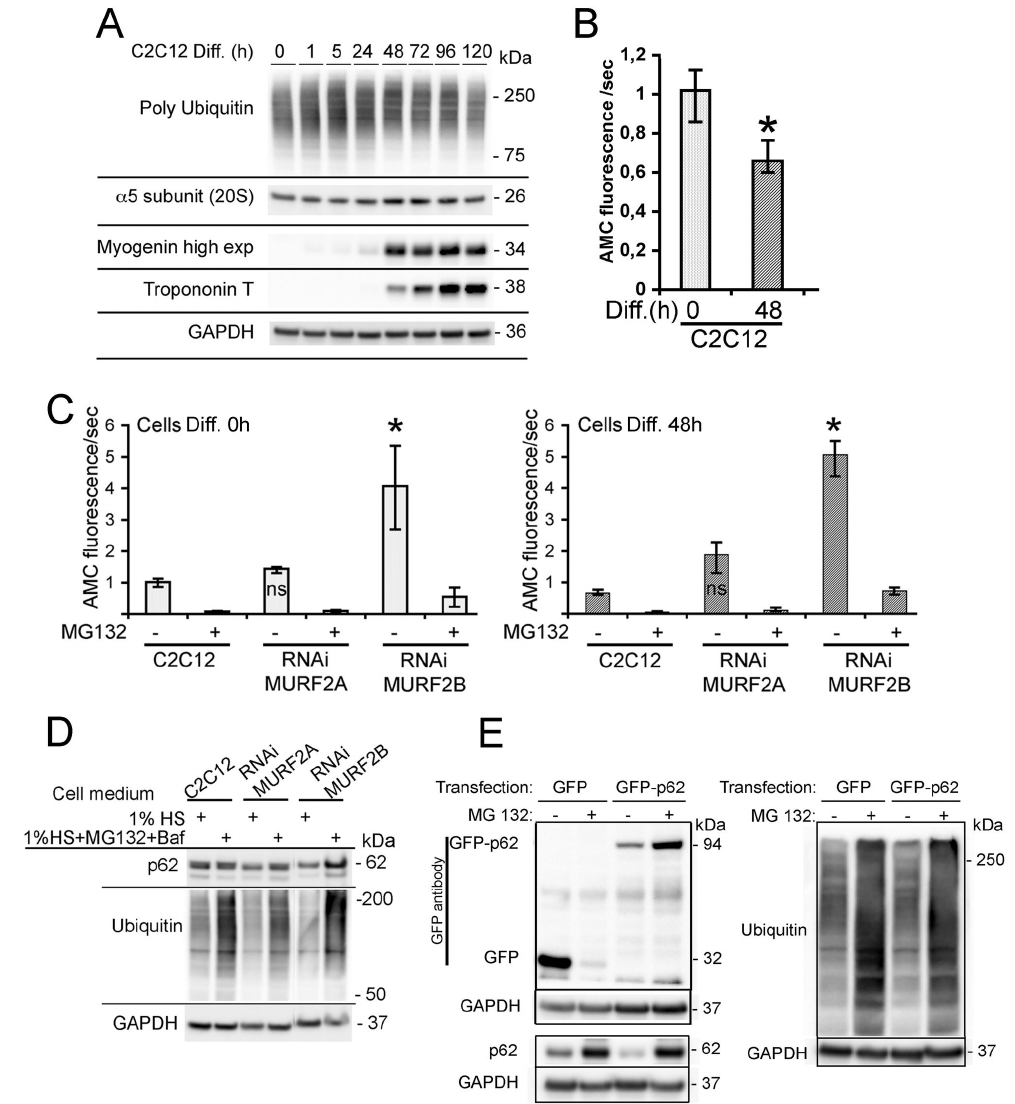
Figure 9. (A) Representative immunoblots of C2C12 lysates probed with poly ubiquitin, the α5 subunit of the 20S proteasome, myogenin, Troponin T and GAPDH antibodies. Lysates were obtained at various times of differentiation (Diff.). (B) Activity of the 20S proteasome in C2C12 cells. Proteolytic 20S proteasome chymotrypsin-like activity of the indicated undifferentiated (0h) and differentiated (48h) C2C12 cells was determined measuring the amidomethylcoumarin (AMC) generated as the cleavage product of the fluorogenic substrat succinyl-leucine-leucine-valine-tyrosine-7 amido-4-methyl-coumarin. Differences were evaluated by the Kruskal-Wallis test. Medians and quartiles are shown in the histograms. Compared to C2C12 myoblasts (Diff. 0h), myotubes (Diff. 48h) showed significant differences (*, P<0.05). (C) Activity of the 20S proteasome in various RNAi cell lines. The proteolytic 20S proteasome chymotrypsin-like activity was determined for undifferentiated (0h) and differentiated (48h) cells as previously mentioned for C2C12 cells. Compared to C2C12 and RNAi MURF2A, RNAi MURF2B cells showed significant increase of their 20S proteasome activity (*, P<0.05). (D) Effect of UPS and autophagic inhibition on p62 expression in C2C12 and MURF2 RNAi cells. After 24h of differentiation in 1% horse serum medium (1% HS), cells were shifted to fresh differentiation medium (1% HS) or treated for 2h 30min with fresh differentiation medium complemented with 50 µM MG132 and 200 nM Baf (1% HS +MG132+Baf) before lysis. Western blots were probed with anti p62, anti mono and poly ubiquitin and anti GAPDH antibodies. (E) p62 is degraded by UPS in differentiated C2C12 cells. C2C12 cells were transfected with vectors encoding GFP or GFP-p62 under the CMV promoter. 24h after transfection, cells were split into two groups, induced to differentiate for 24h, then shifted to fresh differentiation medium containing (+) or not (-) 10 µM MG132 for 12h. Extracts were used for Western blot analyses and probed with the indicated antibodies. Rabbit anti mono and poly ubiquitin antibody was used. doi: